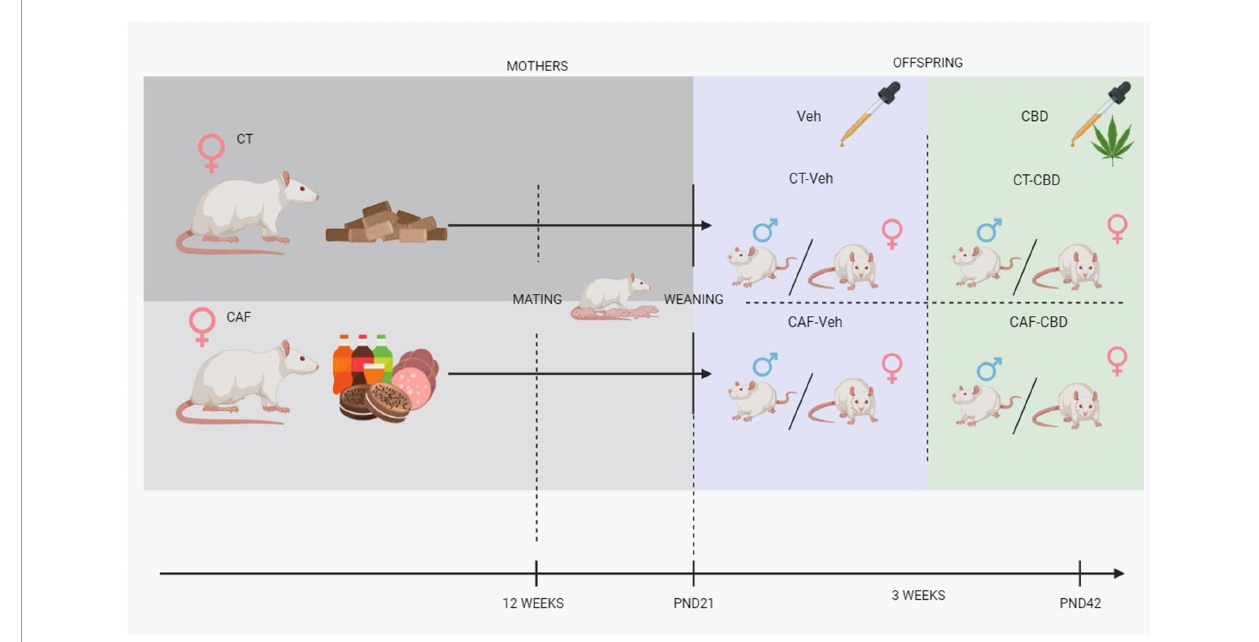
FIGURE1 Experimental design. CT, control chow-fed dam; CAF, cafeteria diet-fed dam; Veh, offspring treated with vehicle (corn oil); CBD, offspring treated with cannabidiol (50 mg/kg); PND, post-natal day.